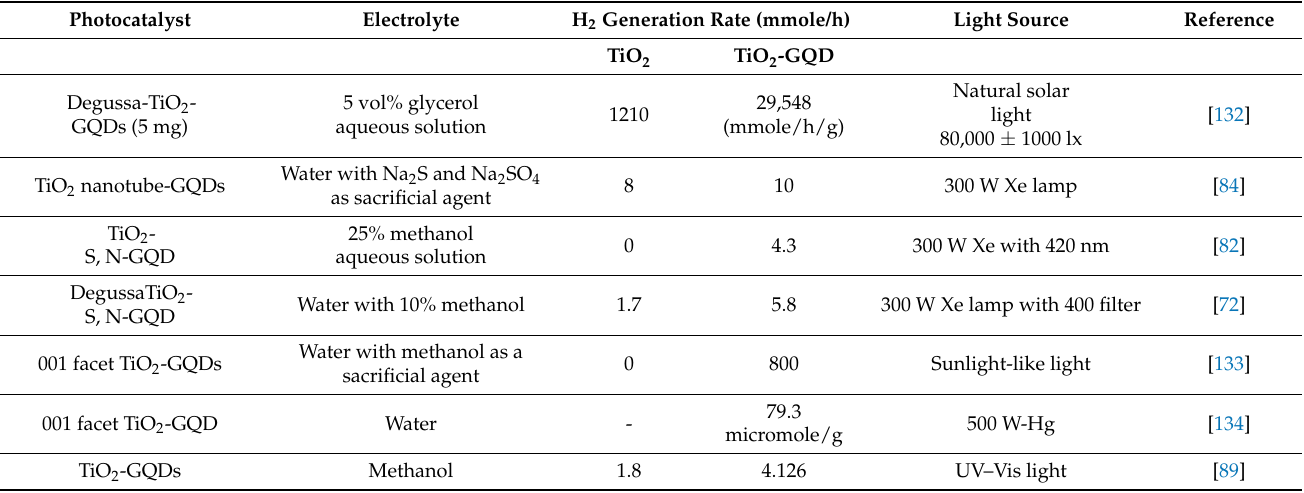
Table 2. TiO 2 -GQD nanocomposites for photoelectrochemical water